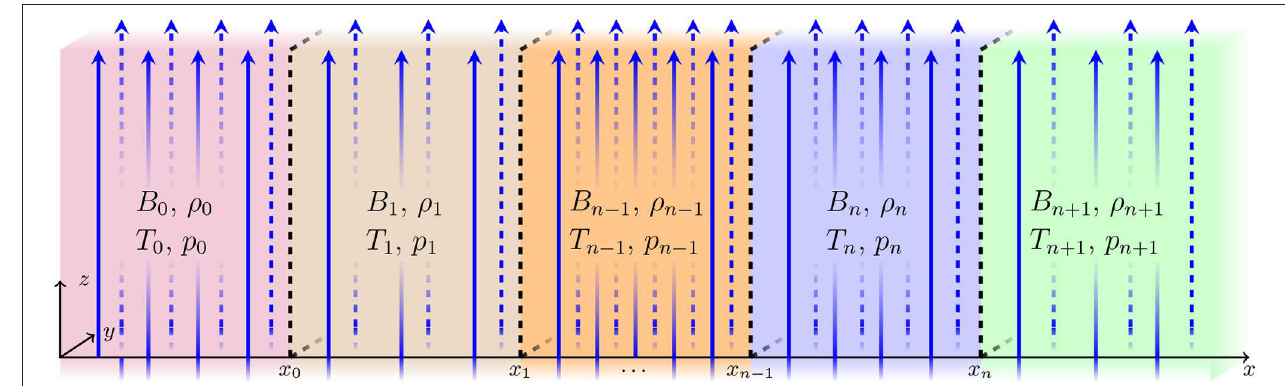
z . The kinetic pressure, p j , 1. + b